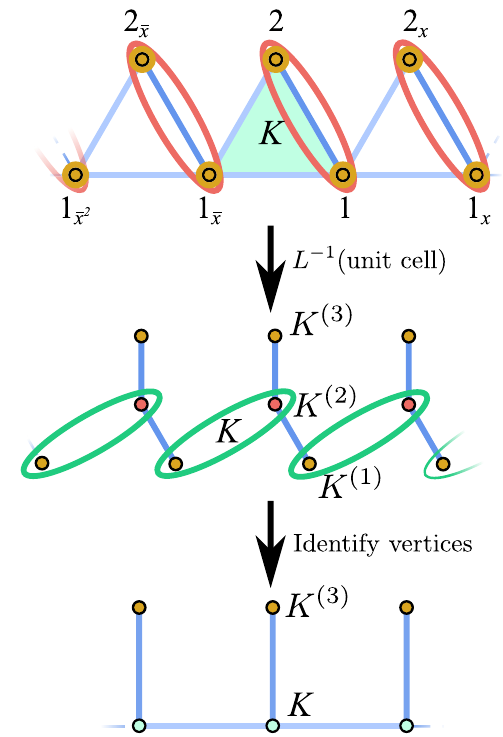
FIG. 5. An illustration of our line-graph recognition algorithm for translation-invariant graphs. (Top) The “triangle path graph.” We first perform line-graph recognition on the individual unit cells, partitioning edges into cliques (circled) such that every ver- tex belongs to exactly two cliques. (Middle) The root graphs of individual unit cells. We next identify vertices according to the connections between unit cells. In this case, we identify K ( 1 ) with to recover the clique K shown in the top figure. (Bottom) K ( 2 ) x After identification, we obtain the correct root